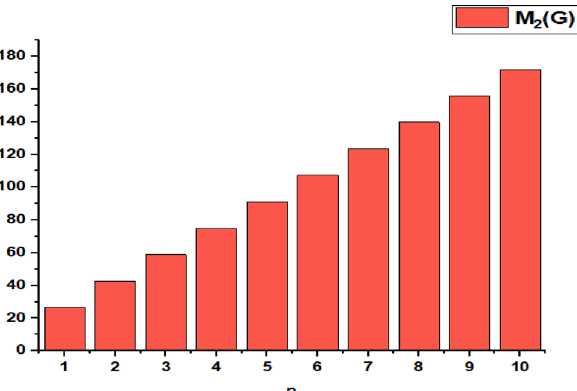
Figure 11. The comparison of n and M 2 ( G )